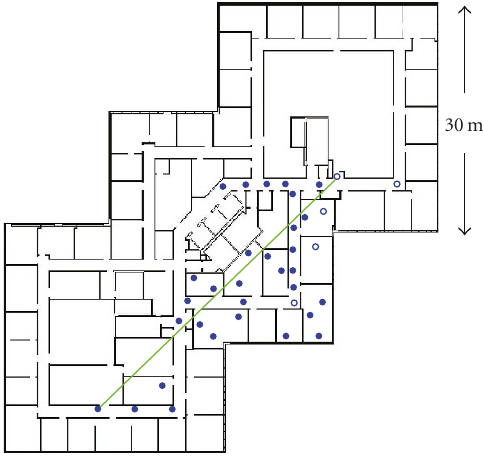
Figure 4: The plan of the NIST North